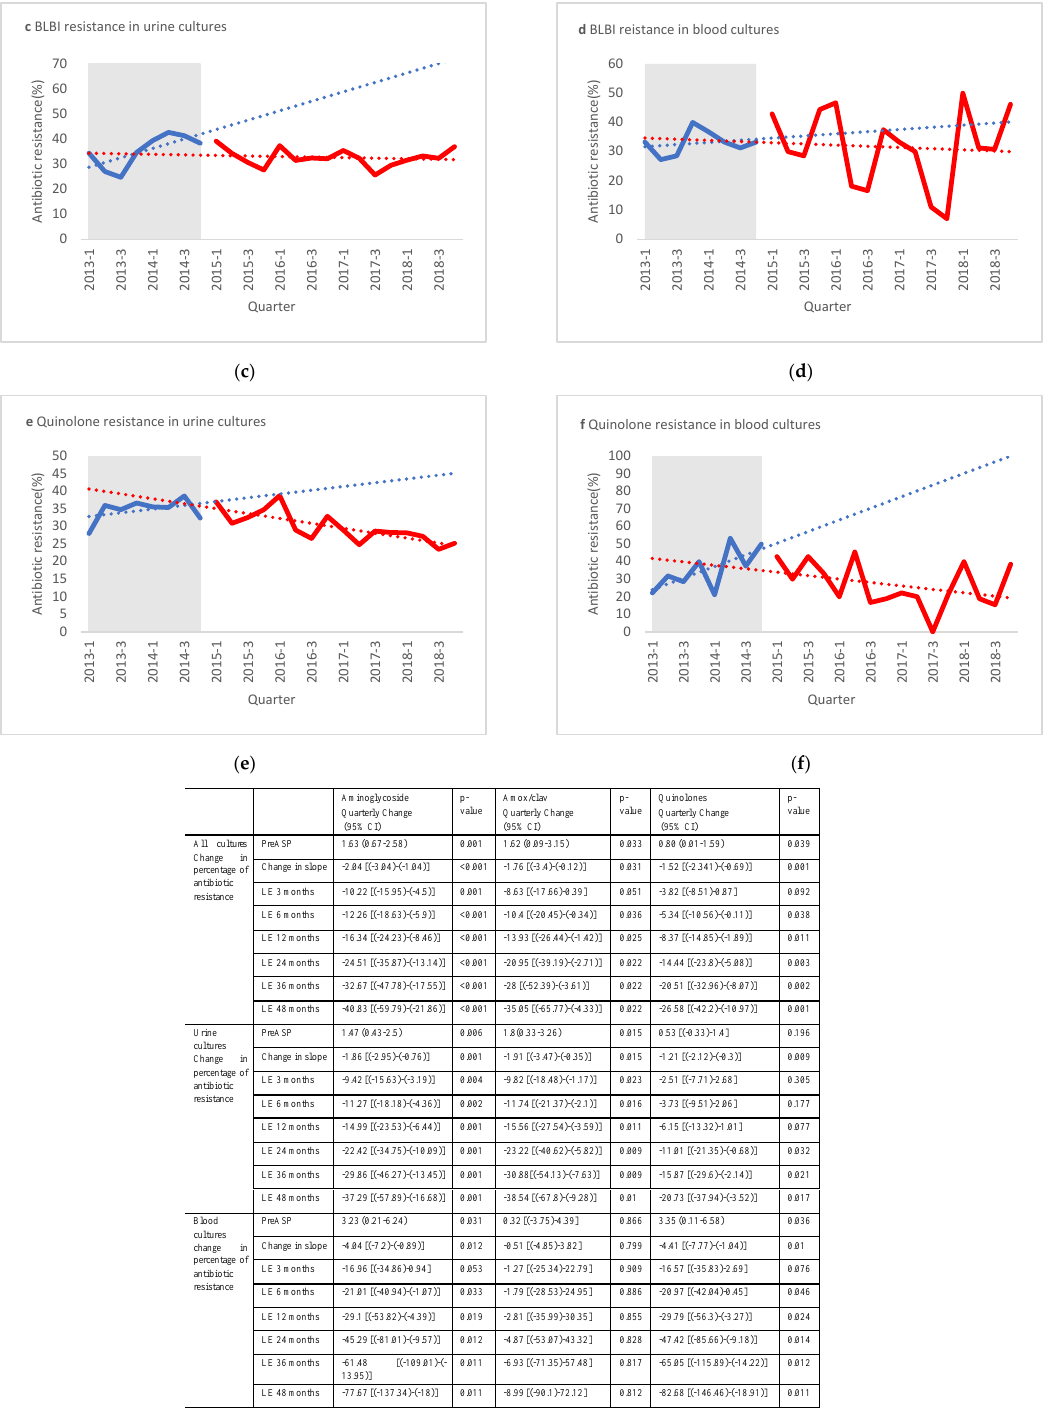
Figure 2. Interrupted time series analysis for antibiotic-resistant E. coli rates in blood and urine cultures. Aminoglycoside resistance in urine cultures ( a ) and blood cultures ( b ). Beta lactam/beta lactamase inhibitor (BLBLI) resistance in urine cultures ( c ) and blood cultures ( d ). Quinolone resistance in urine cultures ( e ) and blood cultures ( f ). Shaded areas present pre-antibiotics stewardship intervention period. ( g ) LE—Level effect, PreASP—Pre-antibiotic stewardship intervention, Amox/clav—Amoxicillin